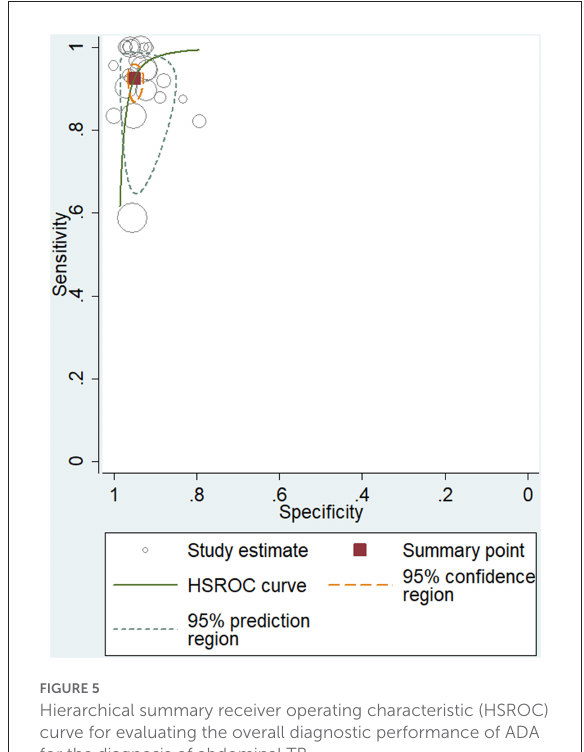
FIGURE6 Deek’s funnel plot asymmetry test for identifying publication bias.